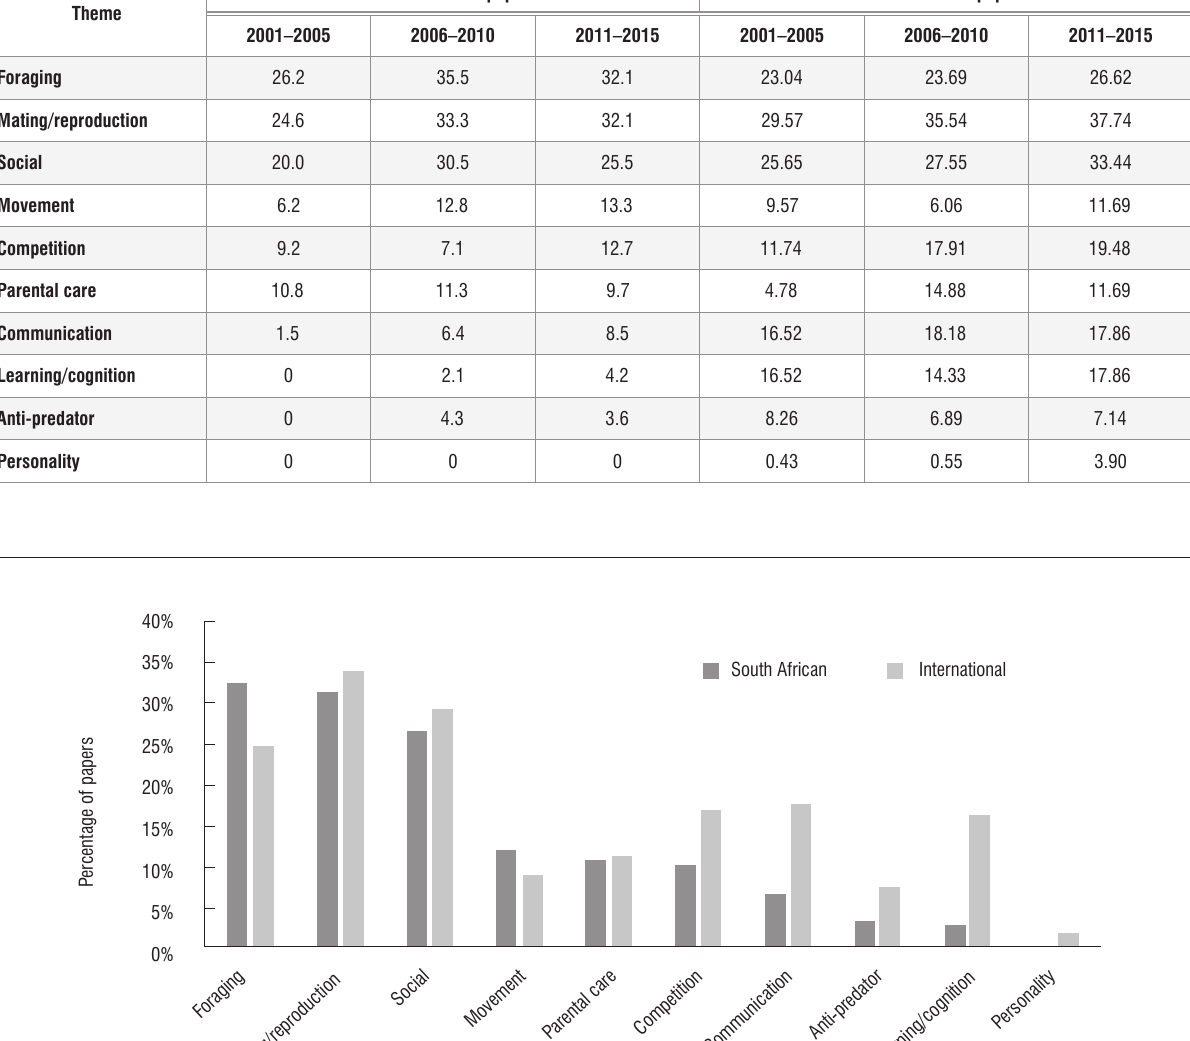
The percentage of papers published within each behavioural theme, across three 5-year blocks. South African papers include at least one South African author, whereas international papers were those works published without South African (co-)authors. %South African papers Theme